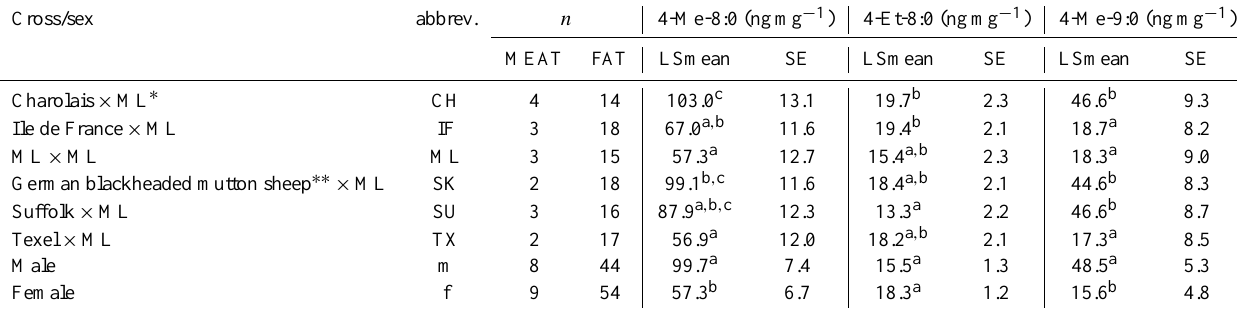
Table 1. Crosses, cross abbreviations (abbrev.), number ( n ) of muscle tissue samples (MEAT), number of subcutaneous adipose tissue samples (FAT) per cross and sex and concentrations of 4-Me-8:0, 4-Et-8:0 and 4-Me-9:0 (ngmg − 1 ) in subcutaneous adipose tissue of different crosses of